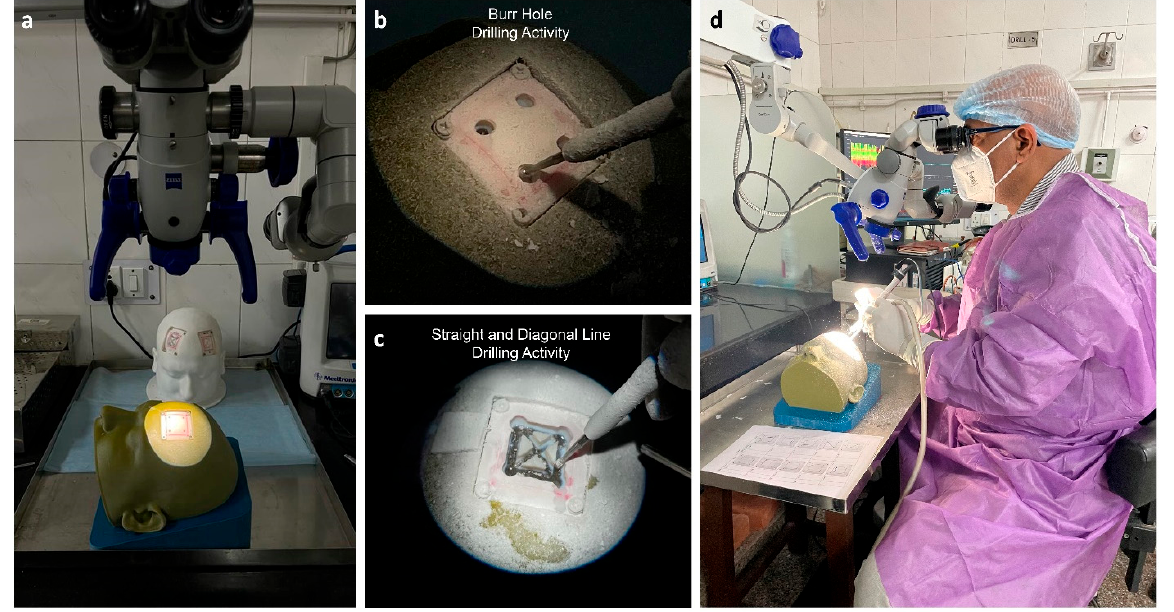
Figure 3. Simulation-based training using a craniotomy simulator. ( a ) Operating microscope and craniotomy simulator, ( b ) burr hole drilling activity, ( c ) straight- and diagonal-line drilling activity, and ( d ) experimental setup.